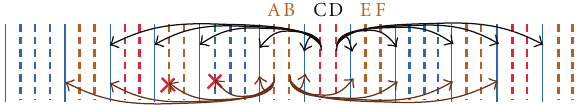
Figure 19: Coulomb transitions of nearest hole pair at ν = 5 / 17.